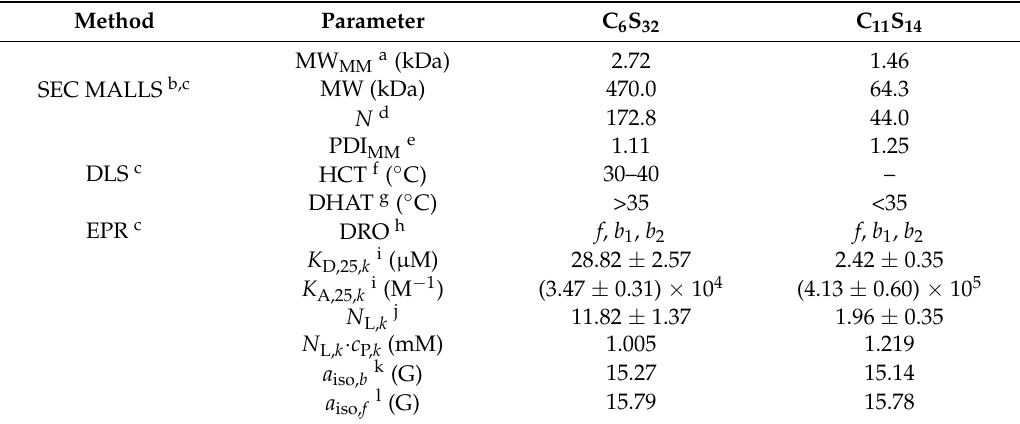
Table 1. Established structural and dynamic parameters of the core-shell polymers